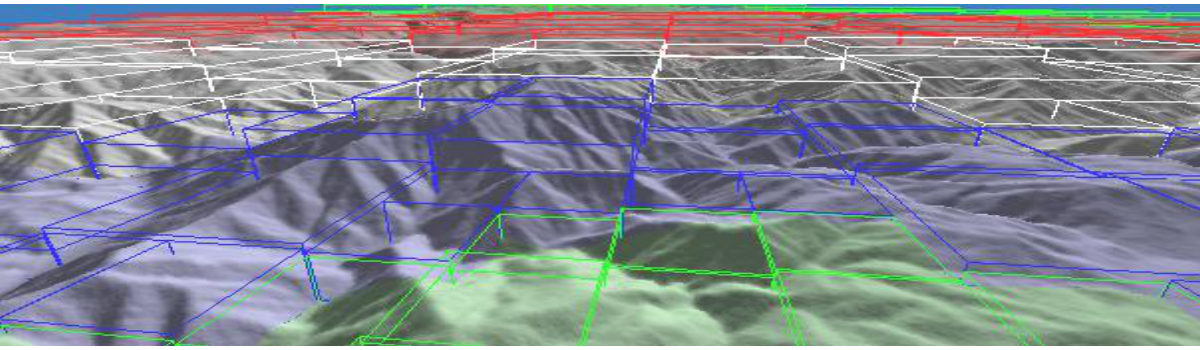
Figure 1. Rendering 3D terrain using region-based multi-resolution